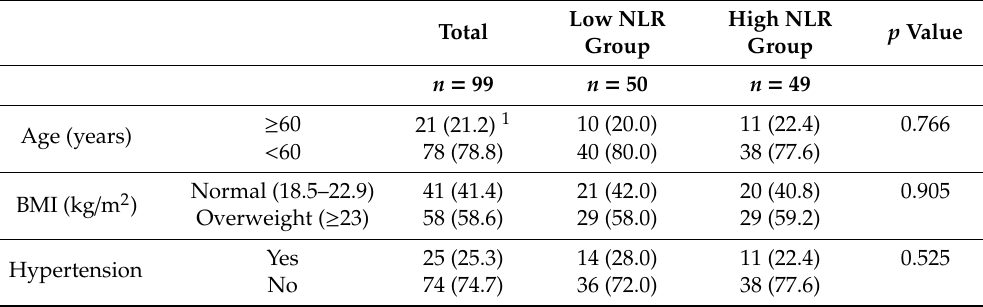
Table 1. Baseline patient